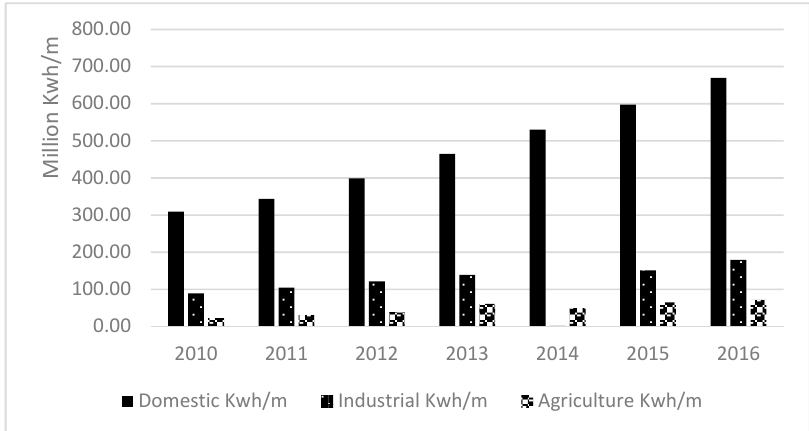
Figure 3. Electricity used in Sudan million KWh (2010–2016). Source: Sudanese Electricity Distribution Ltd 2017.